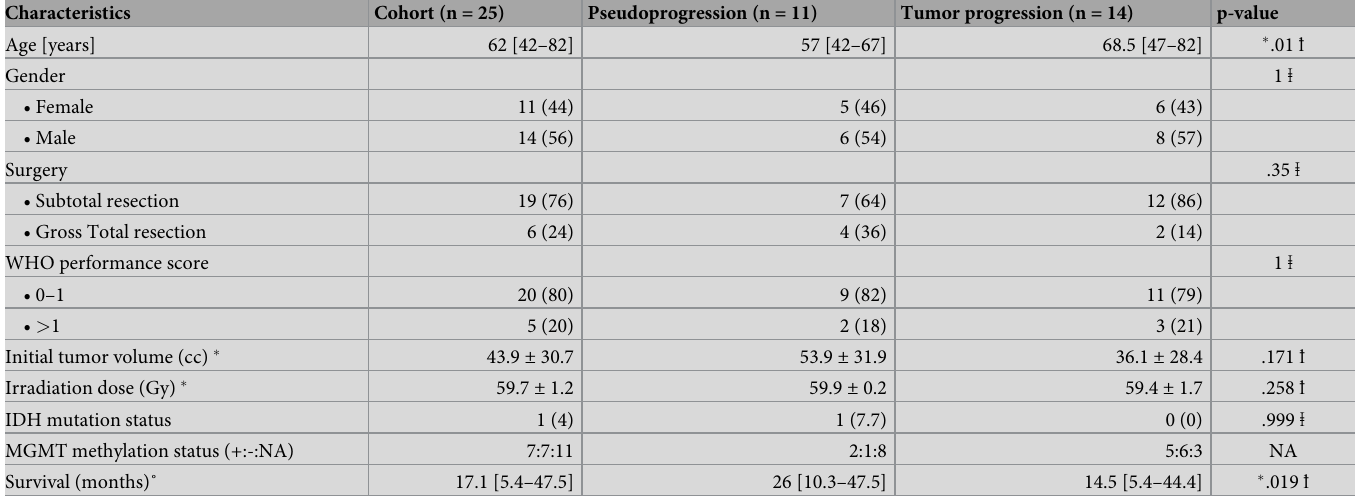
Table 1. Patient